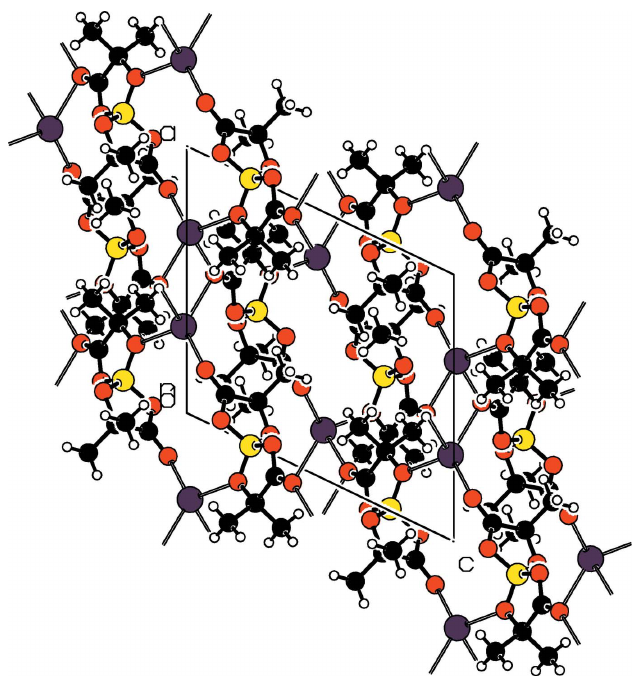
Synthesis and crystallization